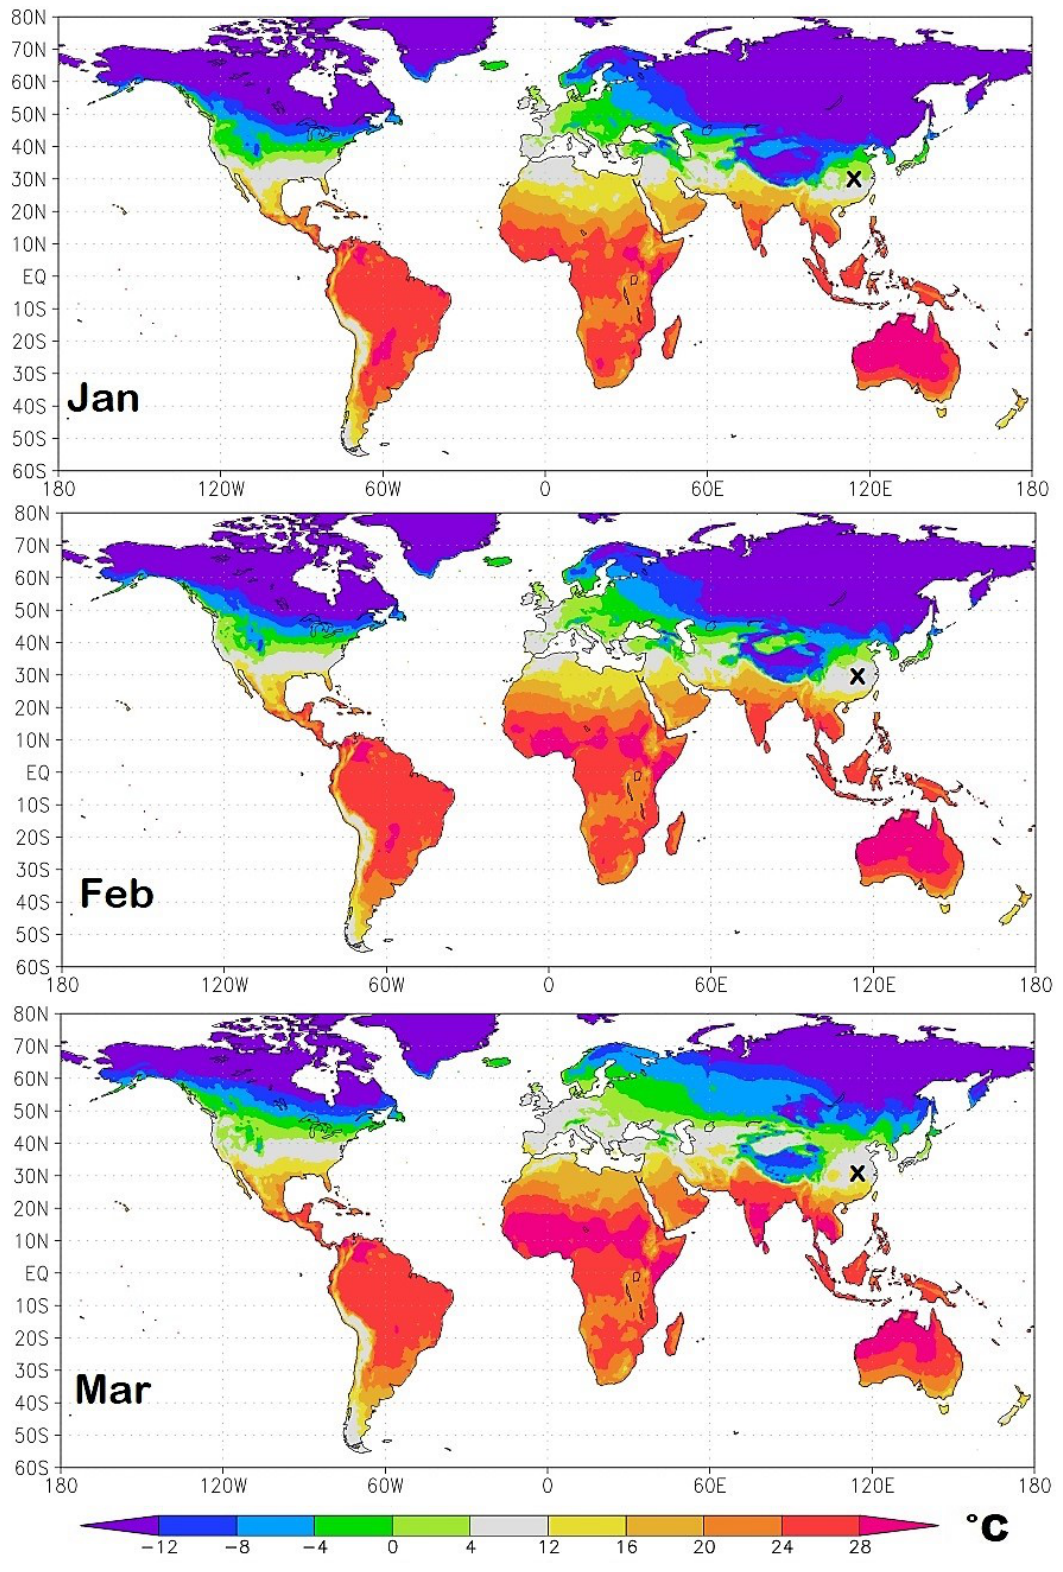
Figure 11. Winter isotherm world maps from January to March. The small x over China indicates the position of Wuhan. The light-gray zone represents the modeled most exposed regions to the COVID-19